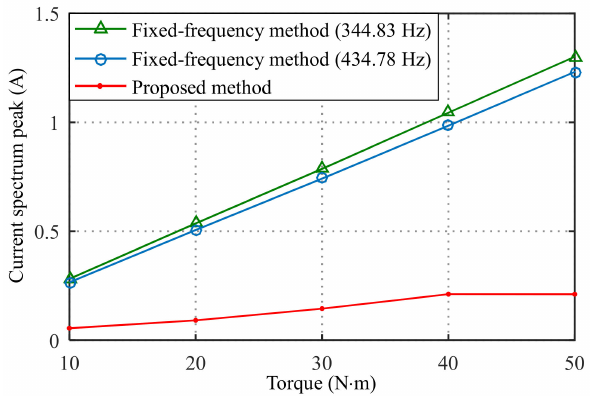
Figure 12. Injection-induced maximum current spectrum peak comparison between the proposed method and the fixed-frequency method under different torque